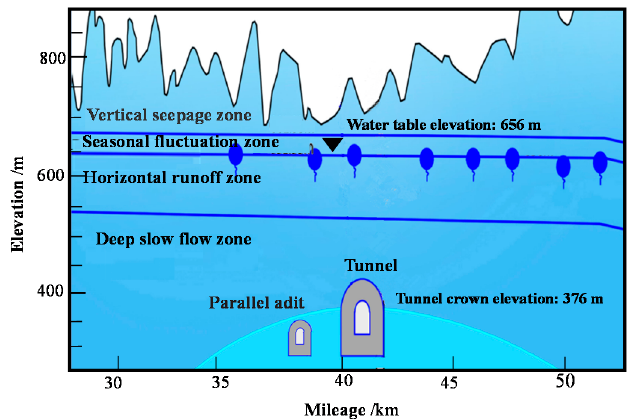
Figure 6. Hydrogeological profile of the Jiajiaoshan Tunnel.